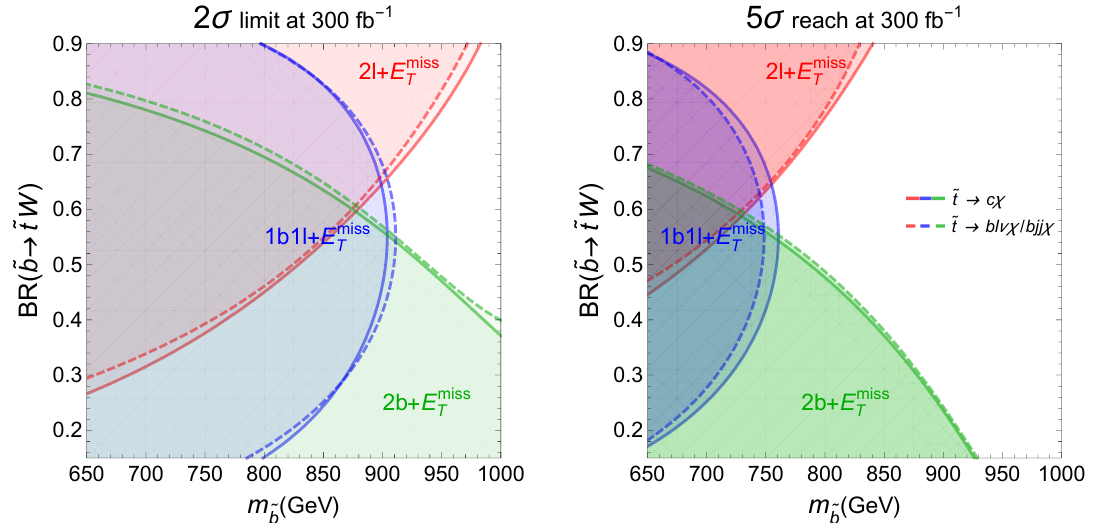
Figure 5 . Expected 2 (cid:27) limits (left) and 5 (cid:27) reaches (right) in the ( m ~ from the 13 TeV LHC with 300 fb (cid:0) 1 data, assuming m ~ The red, blue and green contours indicate the regions excluded by the 2 ‘ + E miss and 2 b + E miss channels, respectively. The solid (dashed) curves corresponds to the stop decay T ~ t ! c (cid:31) (~ t ! bW (cid:3) (cid:31) ! bl(cid:23)(cid:31)=bjj(cid:31) ) with 100% BR. The contours are obtained by scanning the ( m ~ ; BR(~ b ! ~ t W )) plane with a grid spacing of (20 GeV, 0.05) and (cid:12)tting the points to a 2- b dimensional